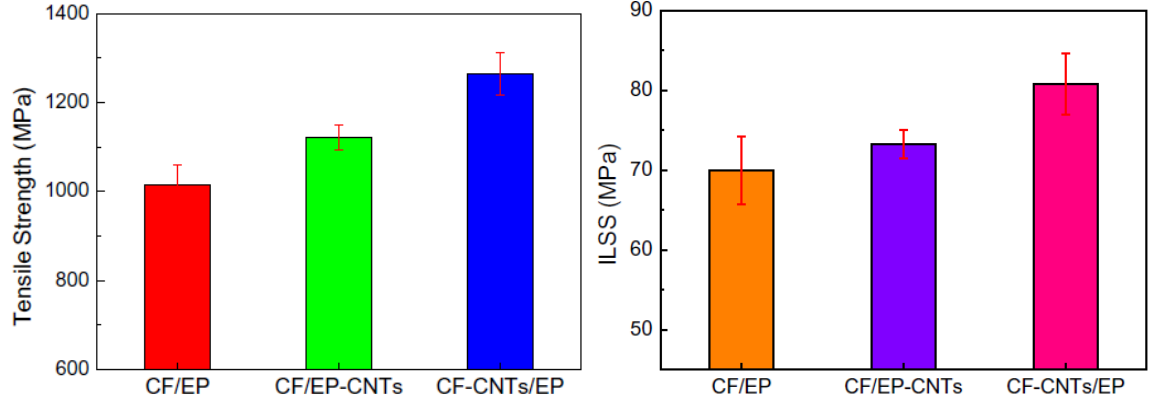
Figure 4. Tensile and interlaminar shear strength of CF/EP, CF/EP-CNTs and CF-CNTs/EP